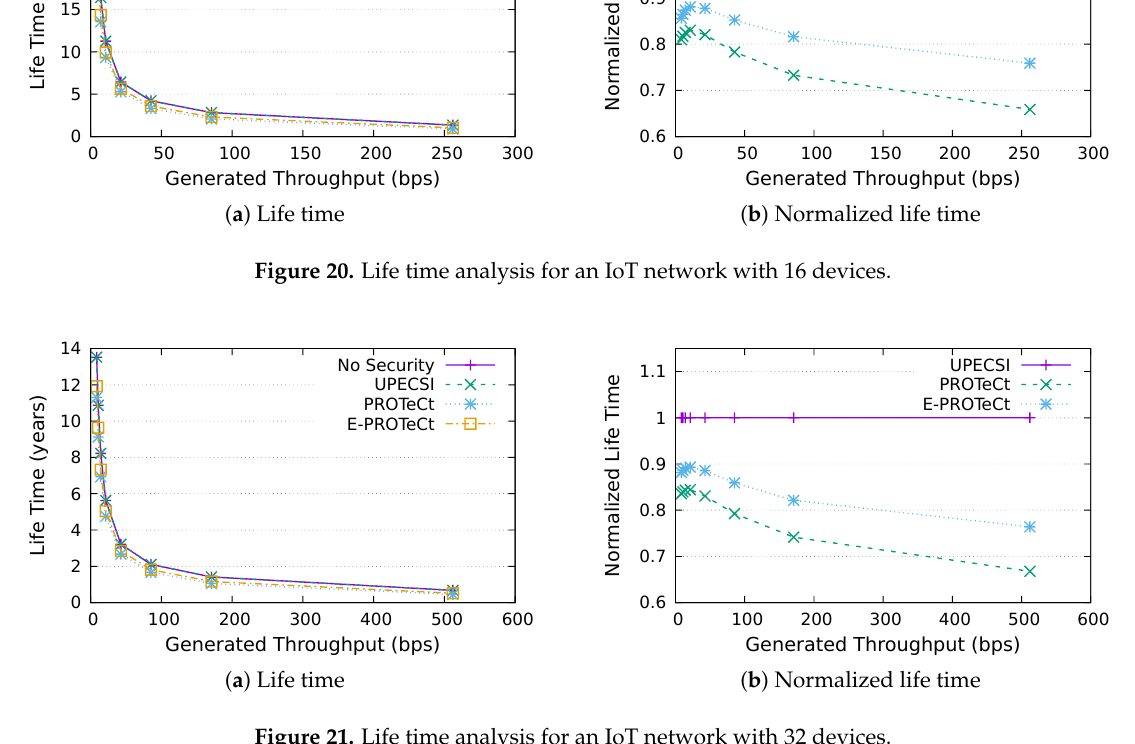
Figure 21. Life time analysis for an IoT network with 32 devices.